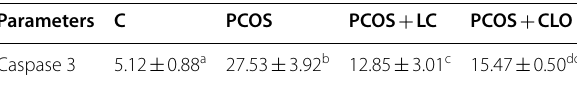
a,b,c,d Means with different superscripts within the same row differ significantly at P < 0.05